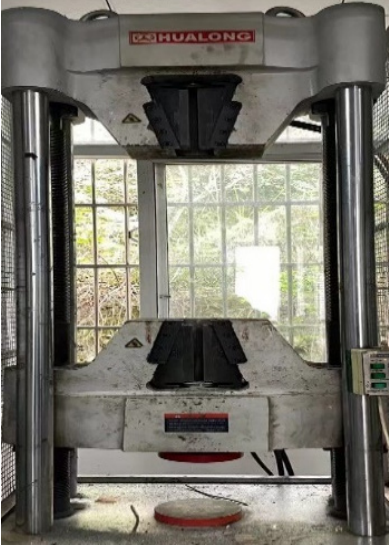
Figure 5. Schematic diagram of test instrumentation.